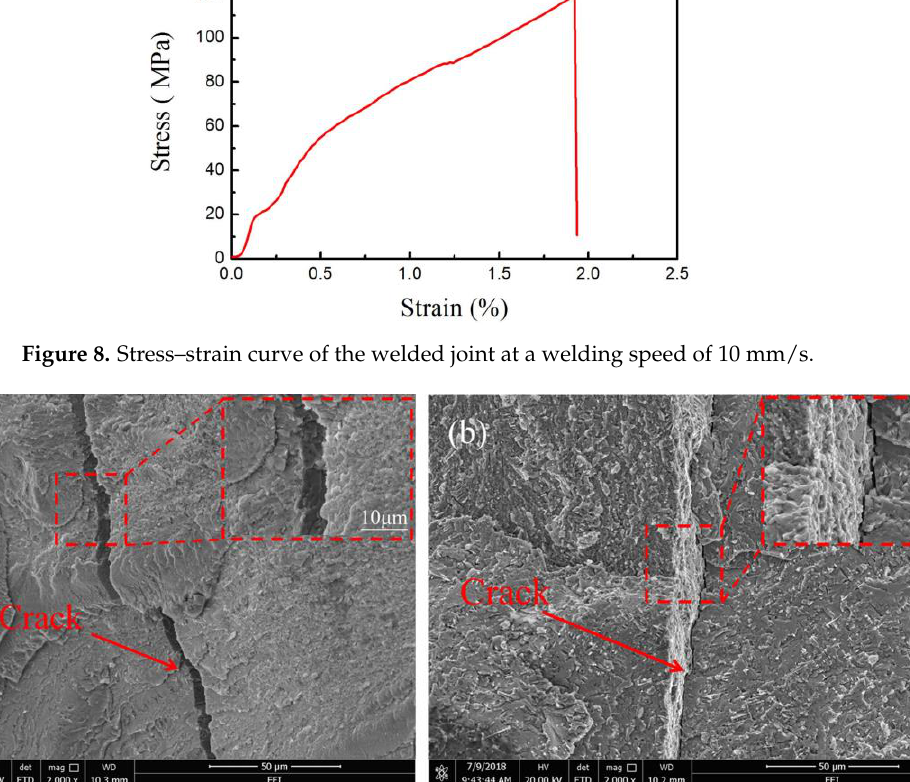
Figure 9. Fracture surface morphologies of the welded joints at welding speeds of ( a ) 6 mm/s (EBW-1) and ( b ) 10 mm/s (EBW-3).